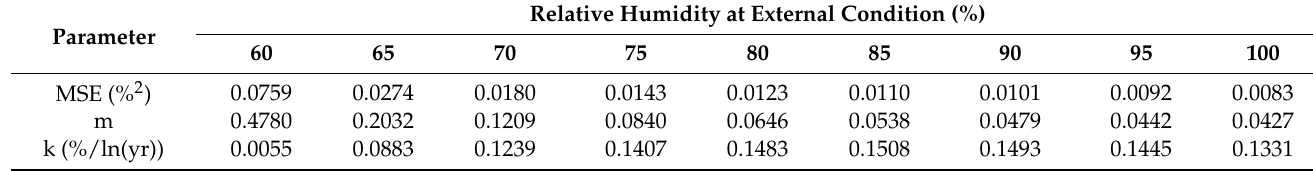
Table 2. Regression analysis on numerical solution varying with relative humidity using analyti- cal